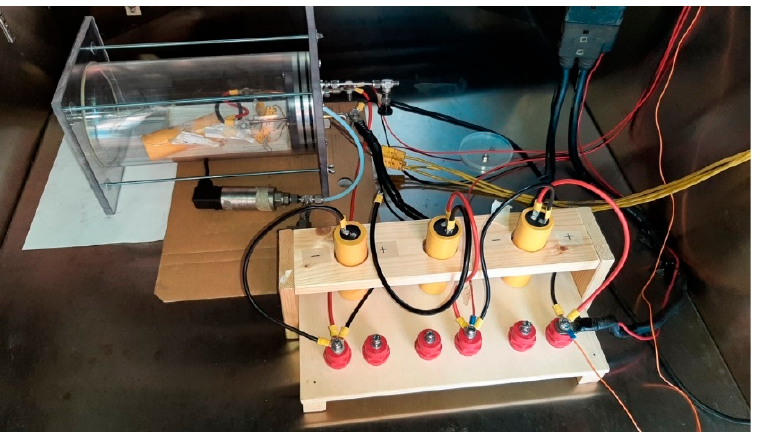
Figure 3. Configuration with four cells in series.